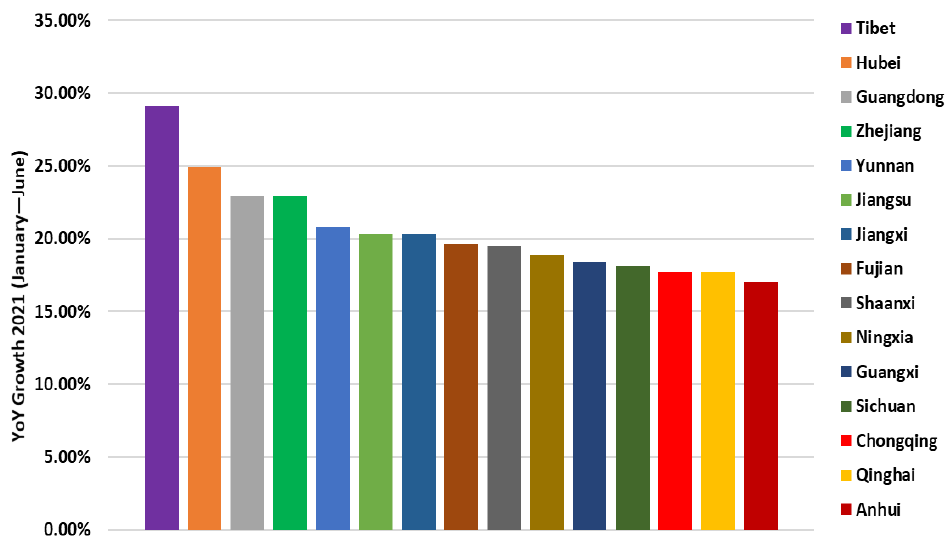
Figure 17. The growth of electricity consumption by region in 2021.